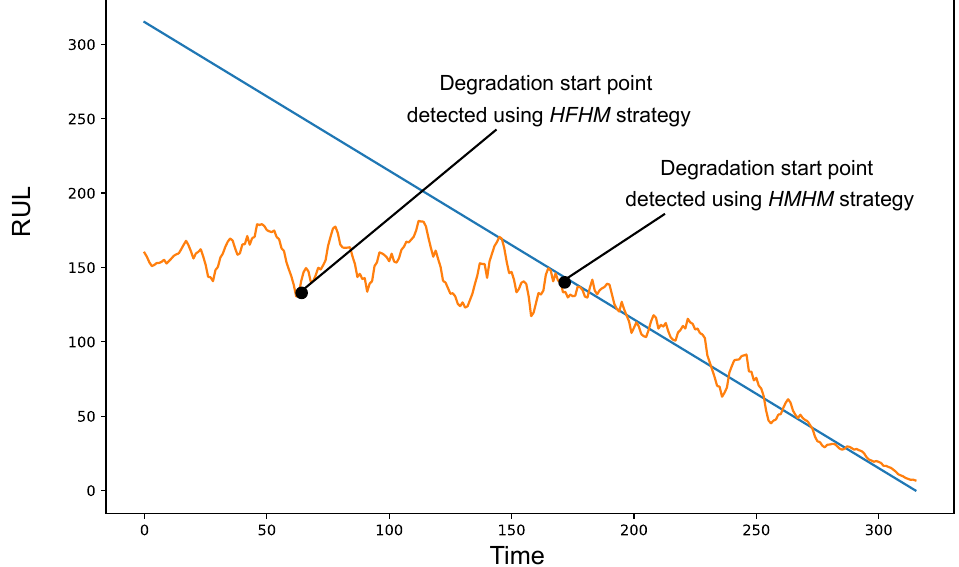
Figure 17. Determination of degradation start point examples. The orange line is an example of RUL forecast obtained using framework [43] for data [18]. The blue line is the expected RUL value.